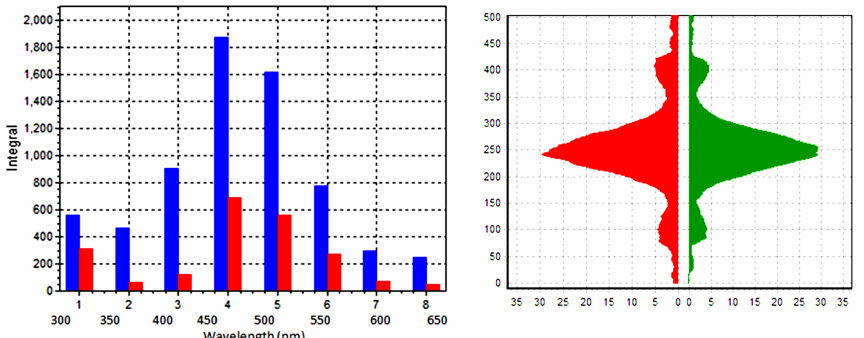
Figure 4. Typical fluorescence spectral data (left) and spatial light scattering data (right) recorded from a single aerosol particle by the MBS